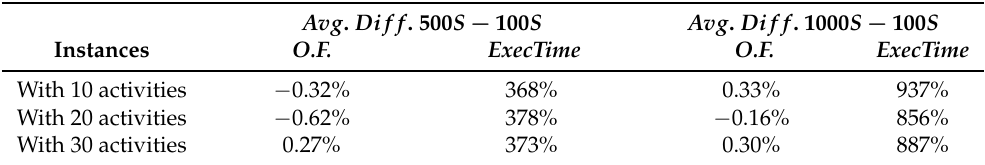
Table 14. Experiment 4 results. Comparisons between the results obtained considering different numbers of